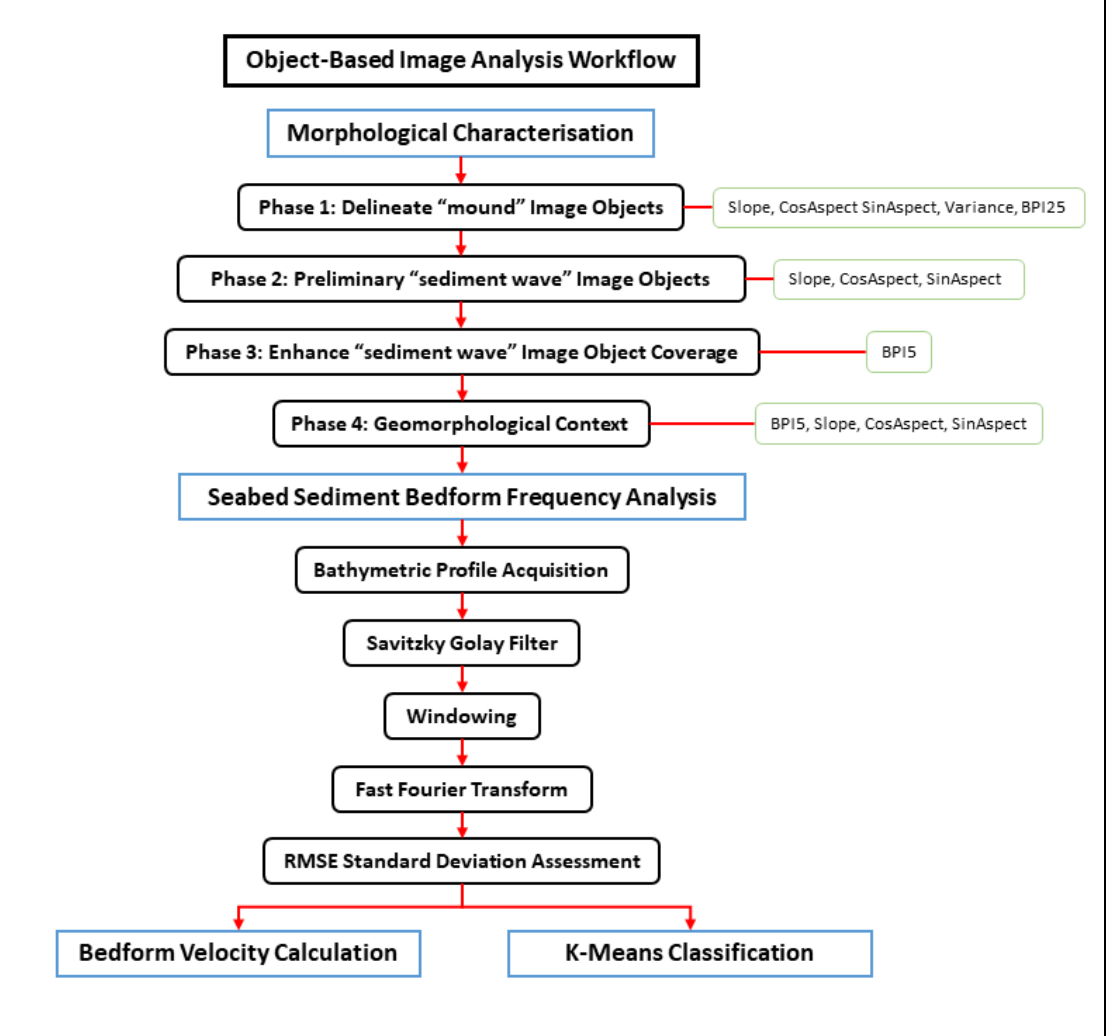
Figure 2. Workflow chart detailing the separate phases for the morphological characterisation, out- lined in black and the image layers deployed during this section, outlined in green. The steps required for the seabed sediment bedform frequency analysis are also mapped out, with the outputs of this analysis feeding into the bedform velocity calculation and the k-means classification.